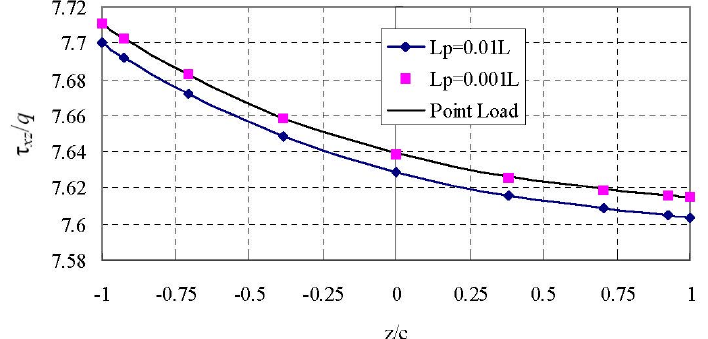
q ) for sandwich panels under xz